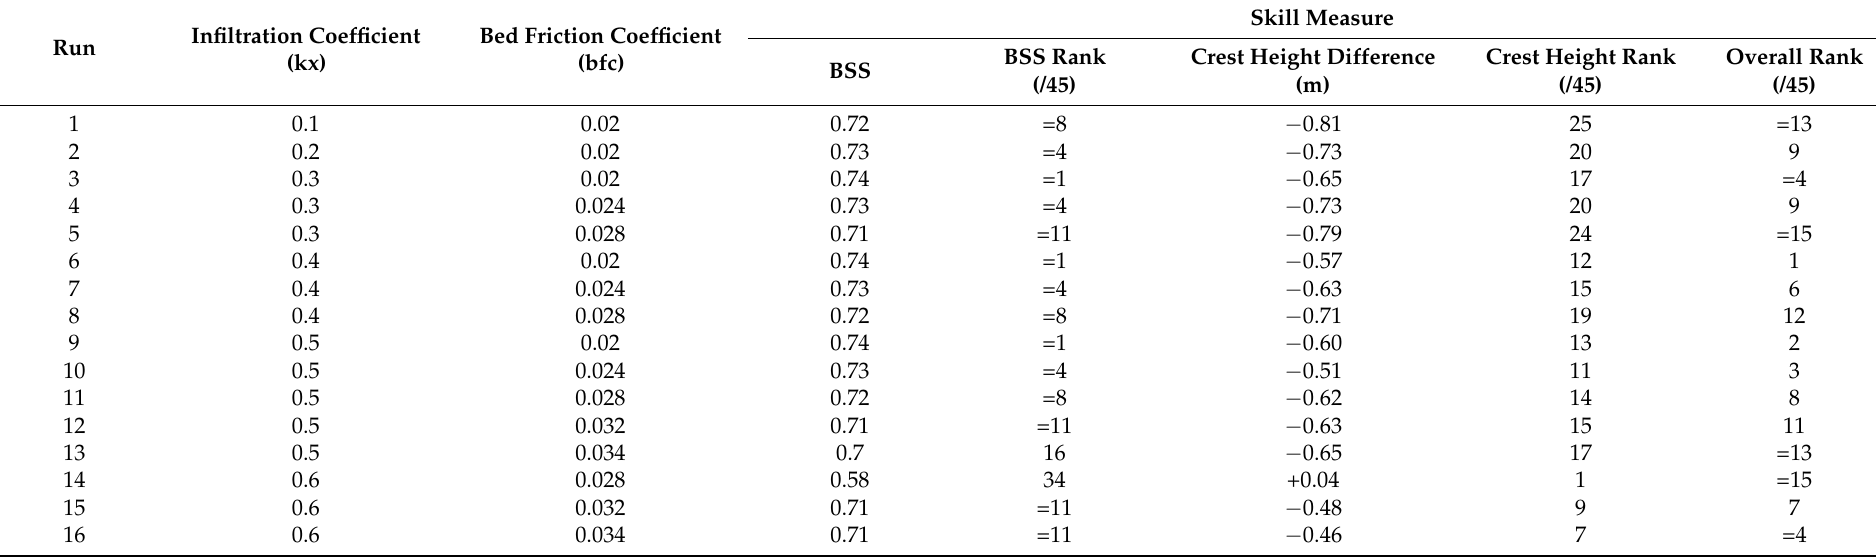
Table 2. XBeach-G model calibration of the profile opposite Salthouse (close to Profile 16, Figure 1c) through systematic variation of free parameters. Assessment of model skill is based on ref [78], the Brier skill score (BSS) can be interpreted with a qualifier: 0.8–1.0 = excellent; 0.6–0.8 = good; 0.3–0.6 = fair; 0–0.3 = poor; <0 = bad. Crest height indicates the difference between modeled and observed post-surge crest height, where negative values indicate that modeled lowering was overestimated. Equals signs indicate a joint rank within the full 45-run calibration